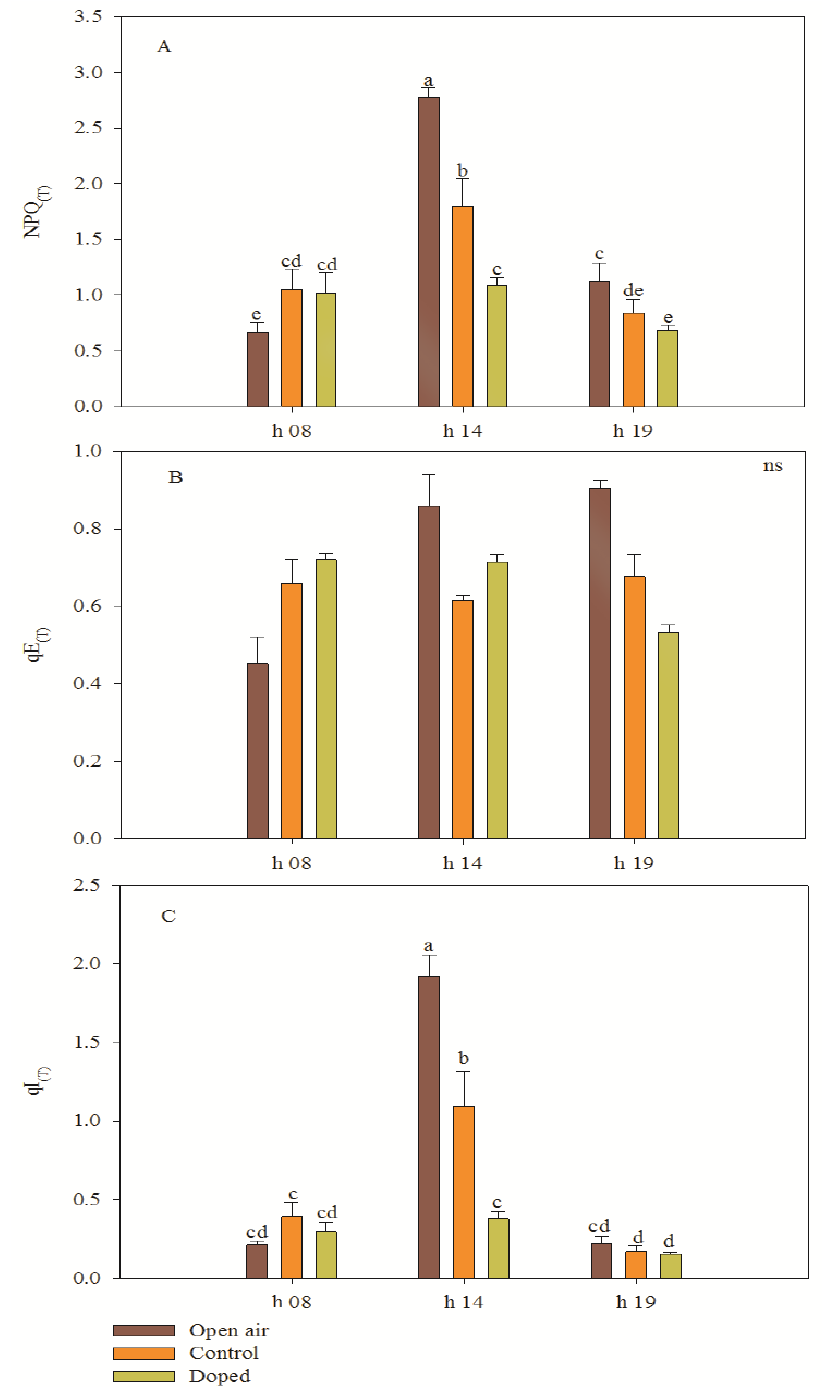
Figure 6. Non-photochemical quenching NPQ (T) ( A ) and its components: the rapidly relaxing q E (T) ( B ) and the slow recovery q I (T) ( C ) as affected by greenhouse cover material (Control: PMMA; doped: PMMA doped with rare earths; open air). Vertical bars indicate mean ± standard error. Different letters indicate significant differences according to Tukey’s HSD test ( p ≤ 0.05); ns: non-significant ( p > 0.05). NPQ, q E and q I are dimensionless ratios (no units); h = hour of the day.